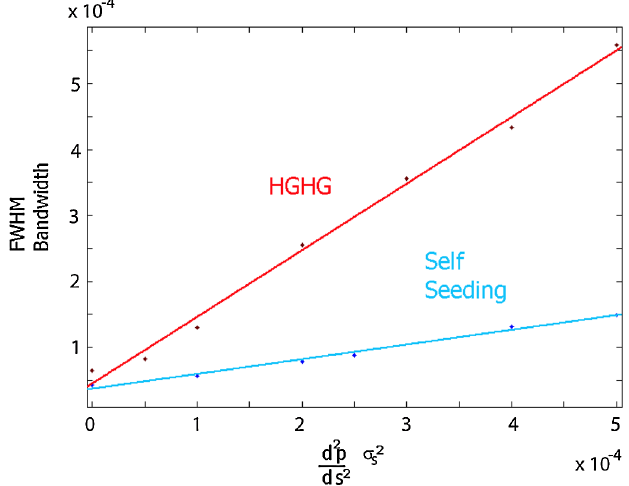
FIG. 6. (Color) FWHM bandwidth at saturation as a function of the quadratic chirp amplitude. The results for self-seeding are averaged over 20 independent